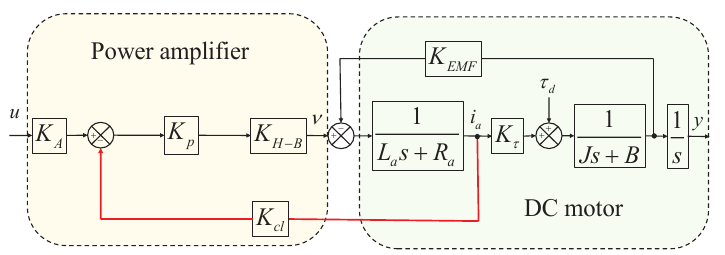
Figure 3. Block diagram of a servo system